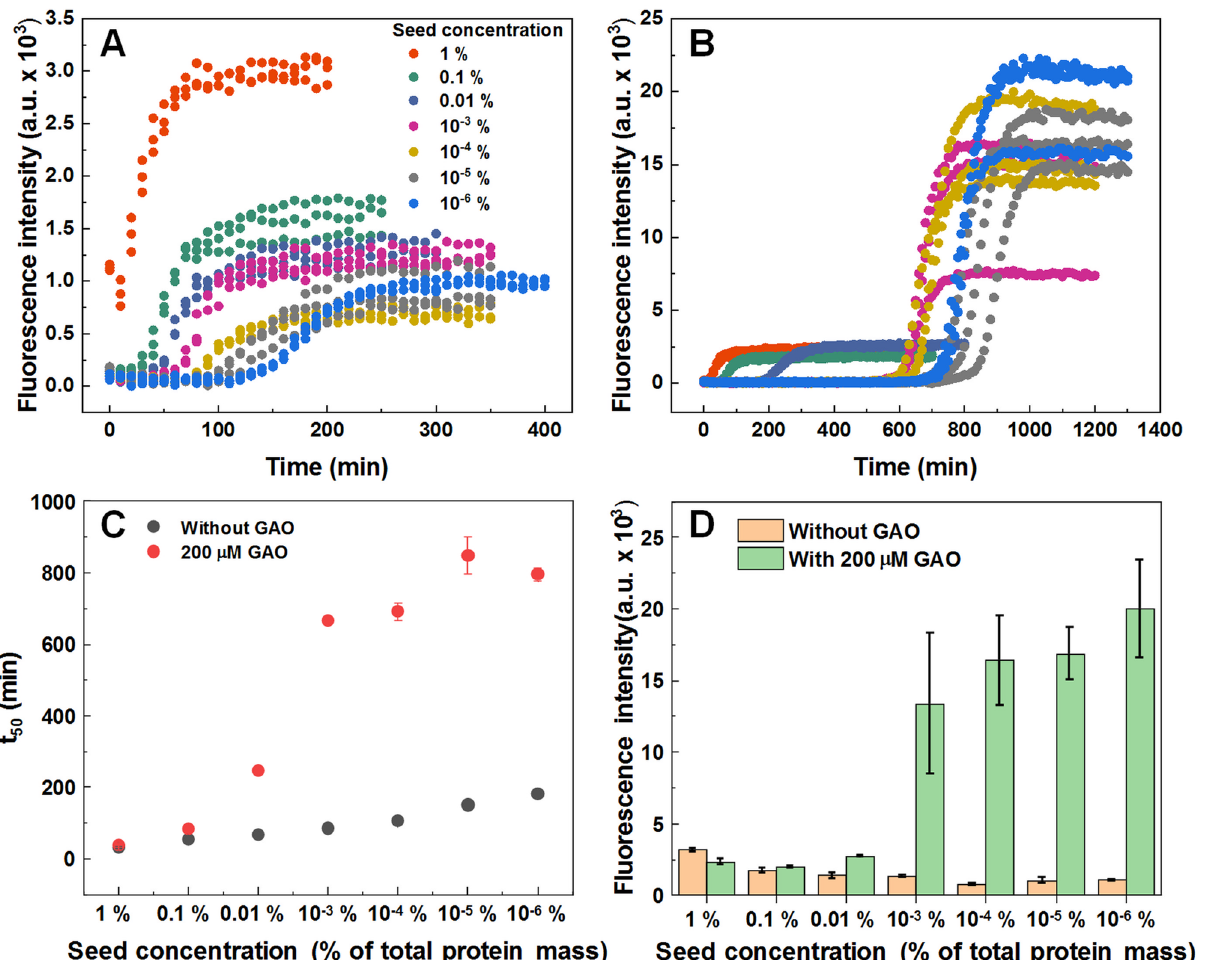
Figure 4. Seeded aggregation kinetic curves of insulin without ( A ) and with ( B ) 200 µM GAO and their t 50 values ( C ). The fluorescence intensity of fibrils formed during seeded aggregation with and without 200 µM GAO ( D